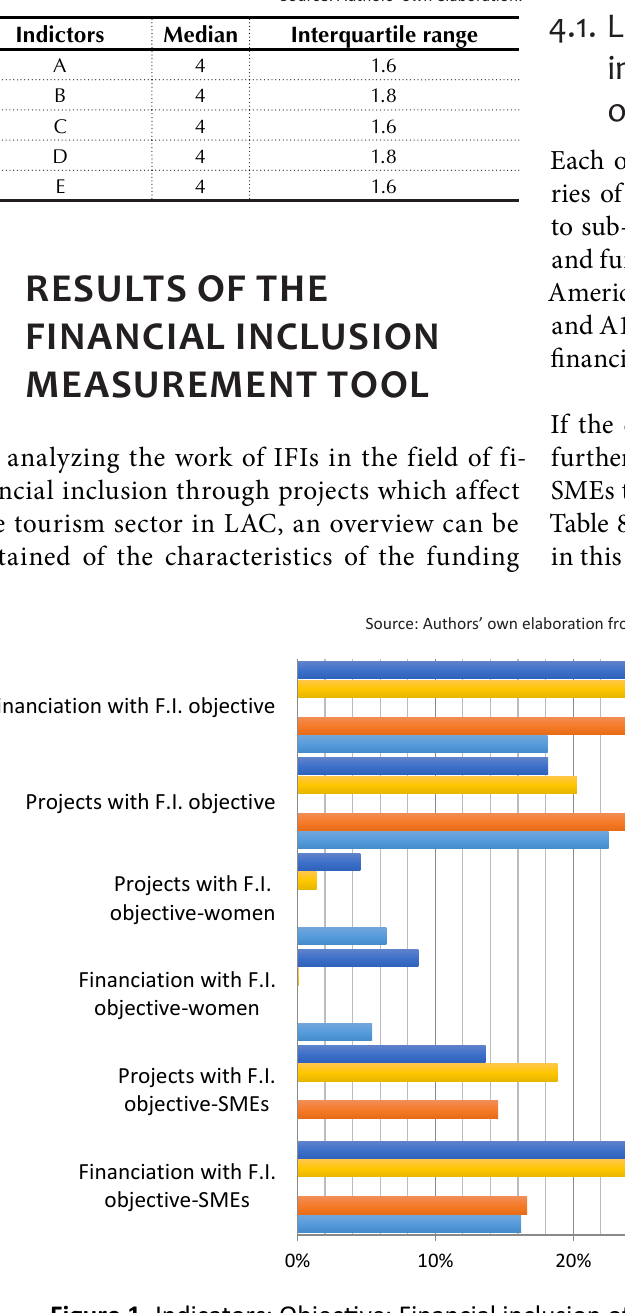
Figure 1. Indicators: Objective: Financial inclusion of women and SMEs, by